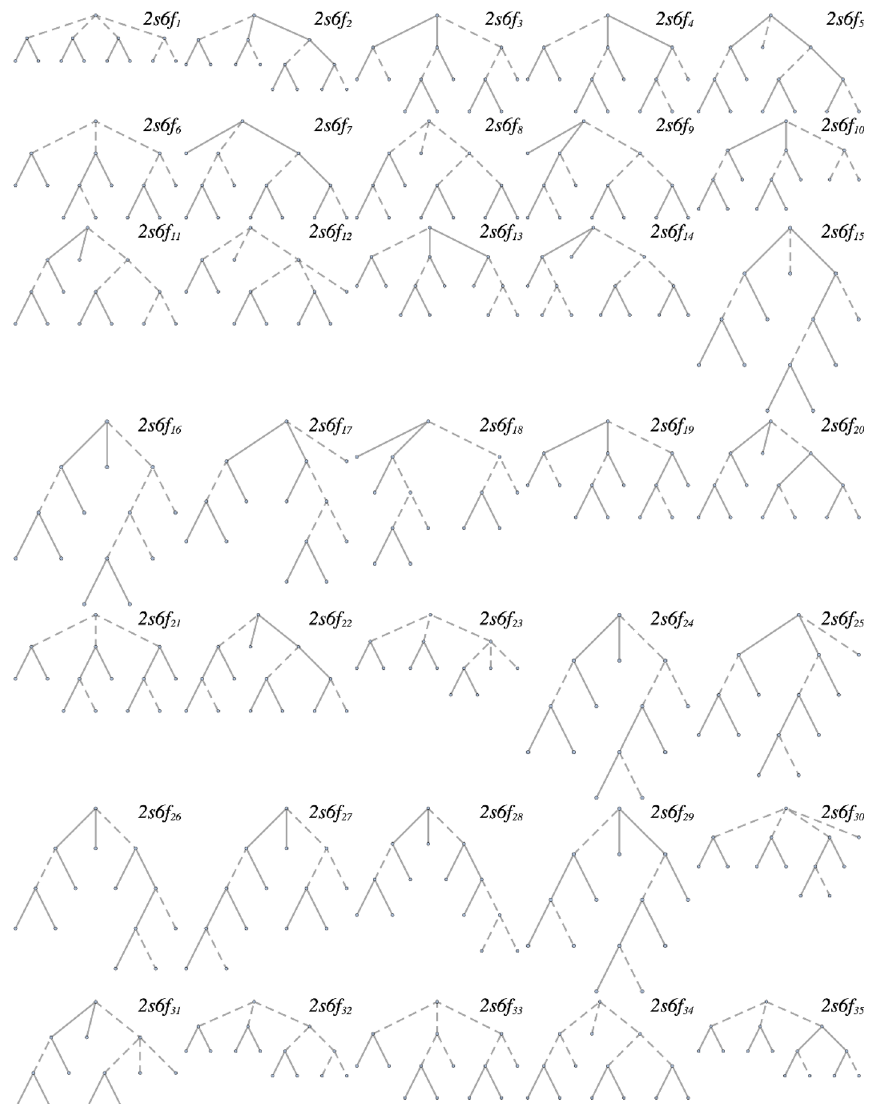
Figure 11. The tree-level topologies associated with the large class of 2 s 6 f dimension-eleven operators in our listing. A number of graphs display the feature — less common at dimension nine — that an exotic field in the diagram couples only to other internal